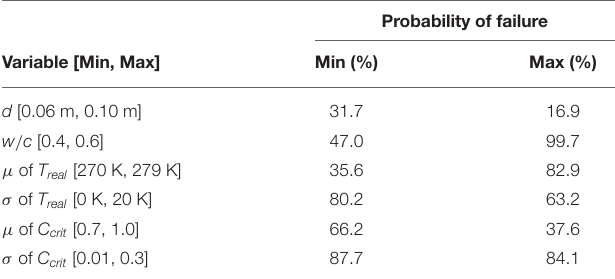
TABLE 9 | Sensitivity